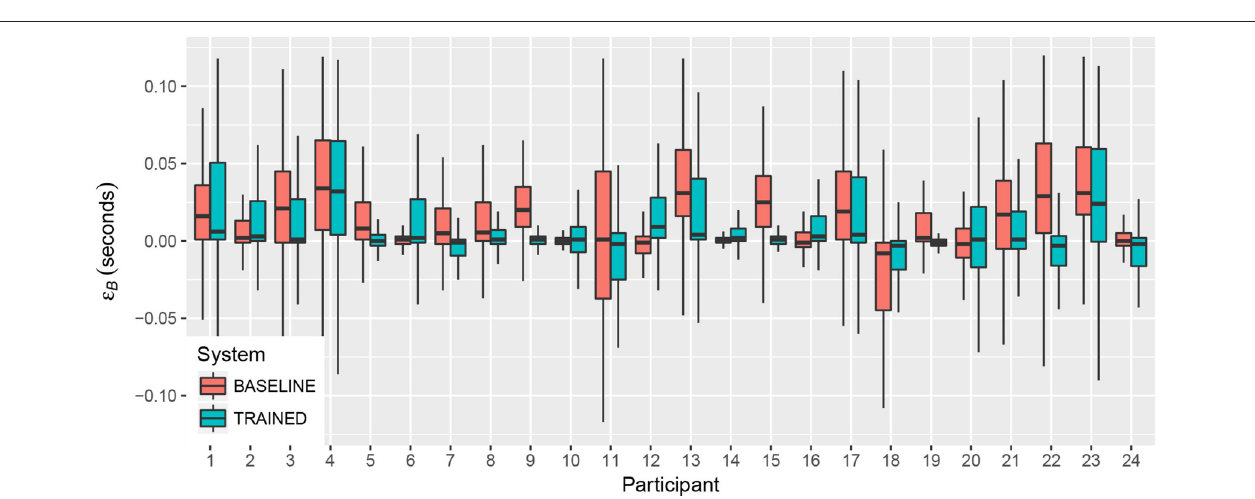
FIGURE 10 | Beat error for both systems, averaged across tasks, for each participant.